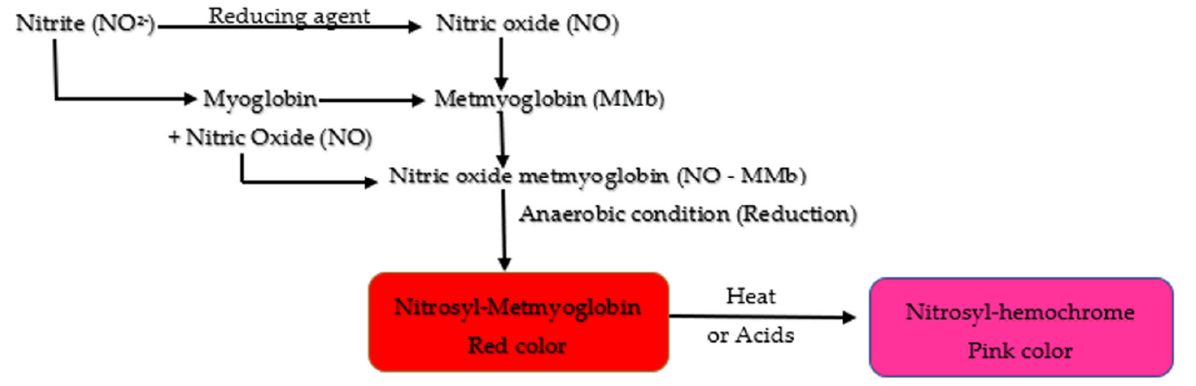
Figure 3. Mechanism of color development in cured meats.